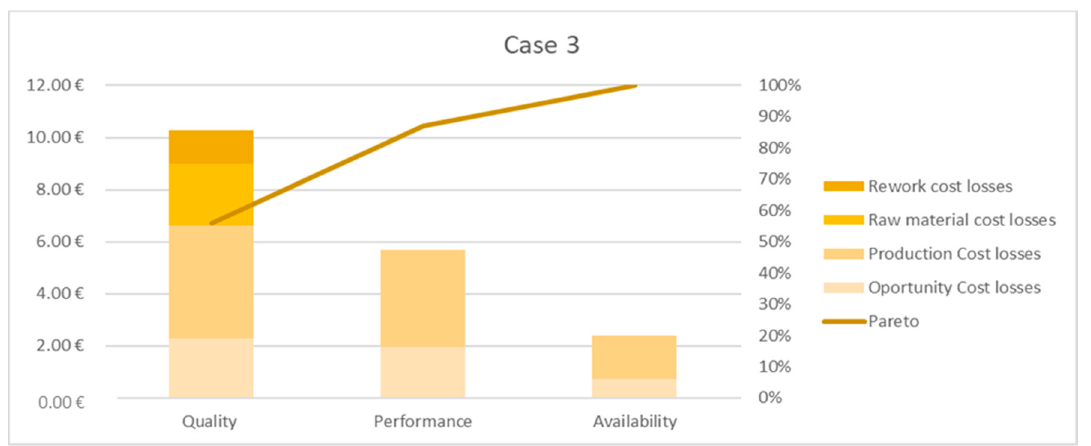
Figure 9. CLI case 3 diagram.